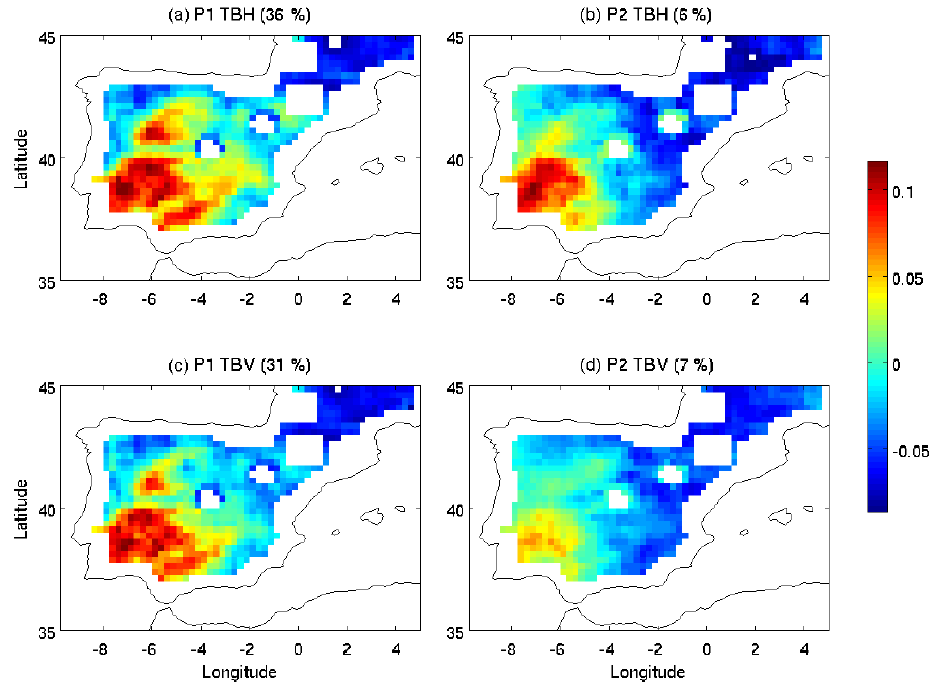
Figure 3. Spatial patterns associated with the first two EOF variation modes (P1 and P2) of the difference between modelled TB (OR- CHIDEE) and measured TB (SMOS). TBH and TBV correspond to the horizontal and vertical polarizations, respectively. The percentage of variance explained by each mode is included in brackets.